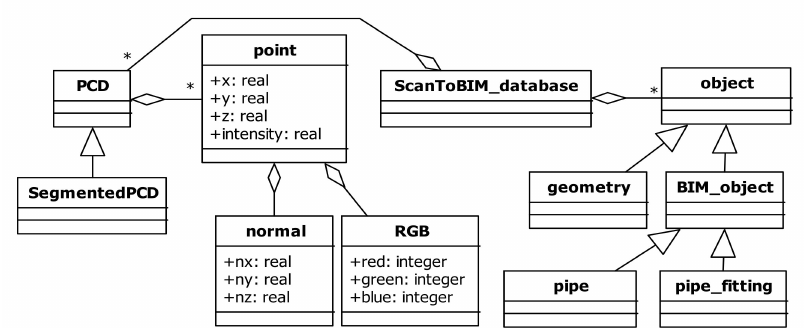
Figure 8. Scan-to-BIM Data